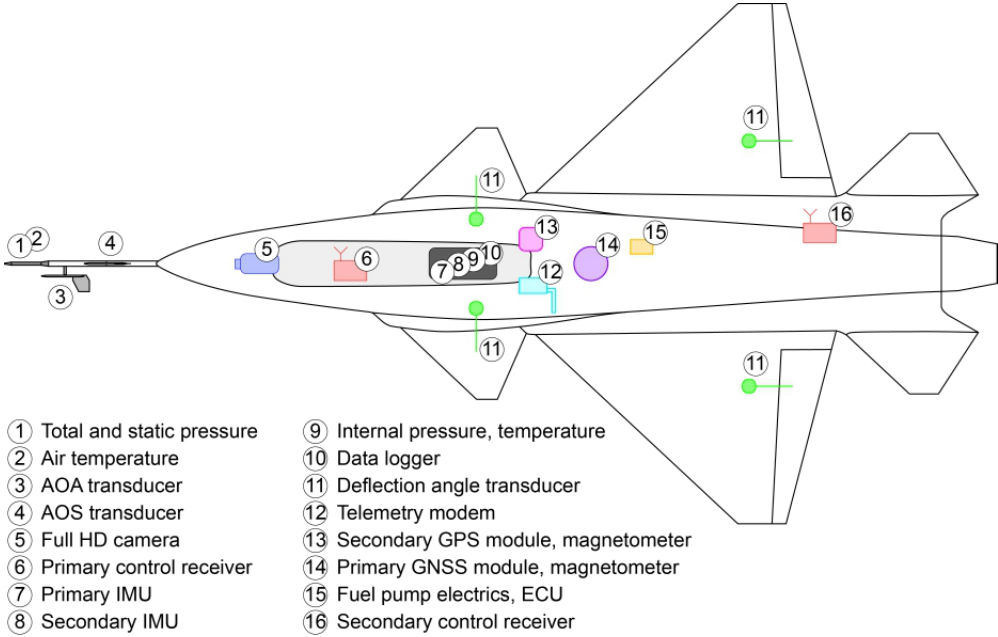
Figure 11. Layout of the data acquisition system on the GFF